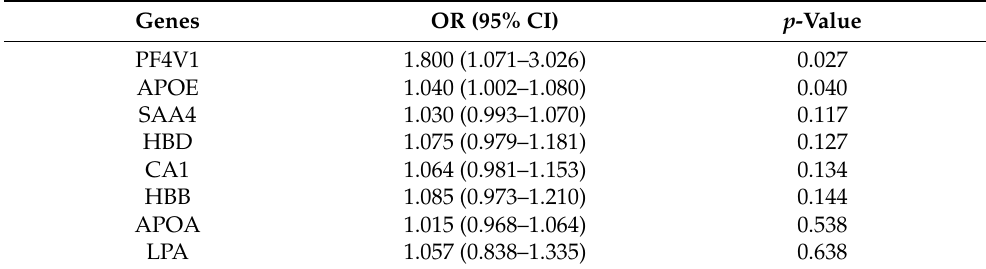
Table 2. Saturated multivariate logistic regression model including all selected exosomes (ApoA, HBB, CA1, LPA, SAA4, PF4V1, ApoE, and HBD), with the outcome EC patients vs. controls. Table 3. Final multivariate logistic regression model including only exosomes significantly associ- ated with the outcome EC patients vs. controls.